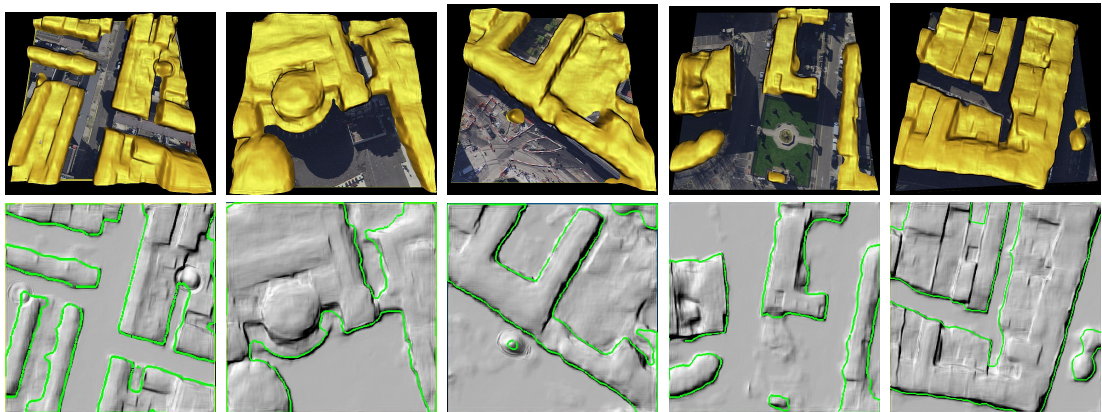
Figure 12. Further processing of our DSM estimates for mapping: 3D reconstruction and 2D building footprint detection. 3D mesh is obtained via Delaunay triangulation with shading.